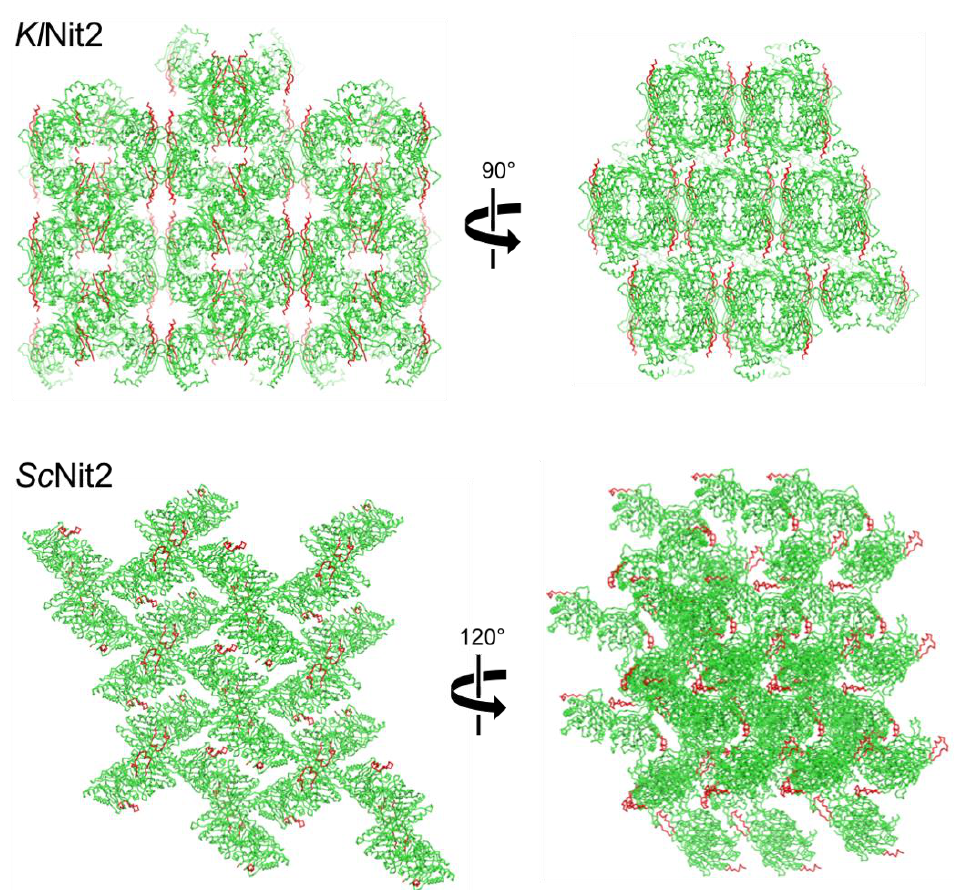
Figure 6. Crystallographic packing of Nit2 proteins. Comparison of crystallographic packing of KlNit2 and ScNit2. The figures were generated using the graphics program PyMOL (Schrödinger Inc., New York, NY, USA).